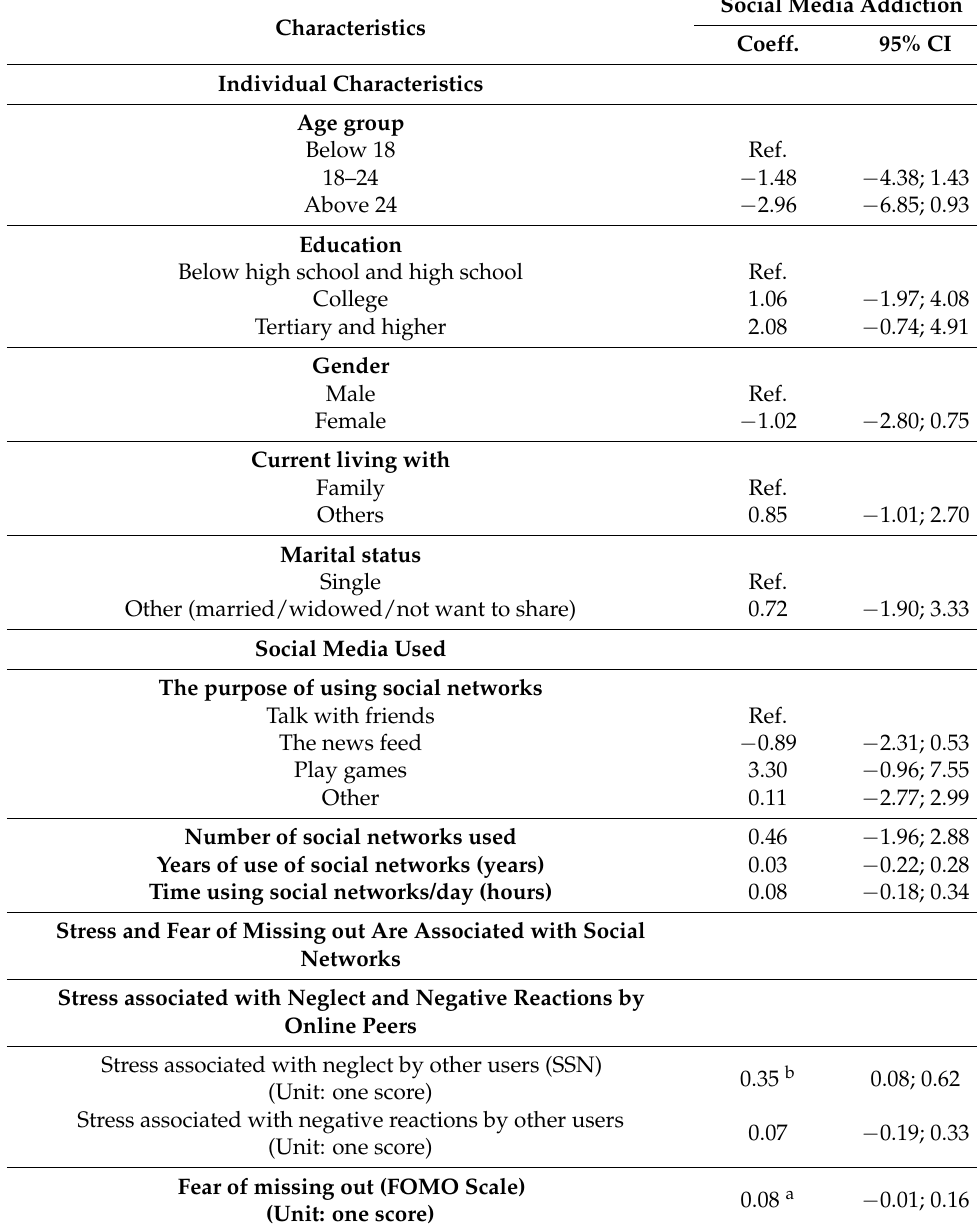
Table 4. Multivariate logistic regression for factors associated with social media